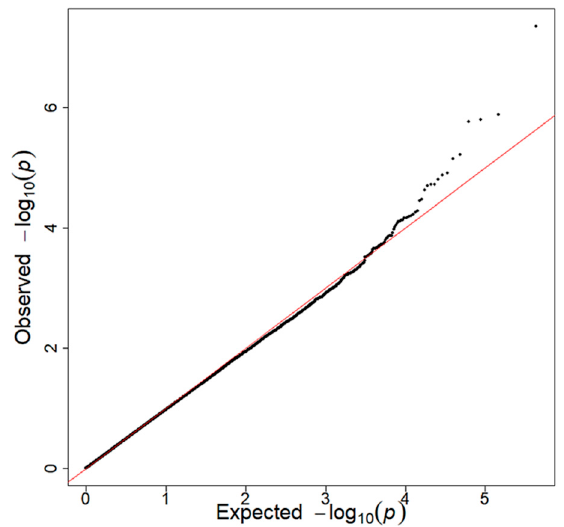
Figure 3. A quantile–quantile plot for the genome-wide meta-analysis showing the p value distri- bution. The x -axis represents theoretical − log 10 p values, and the y -axis represents observed − log 10 p values. The red line indicates y = x.